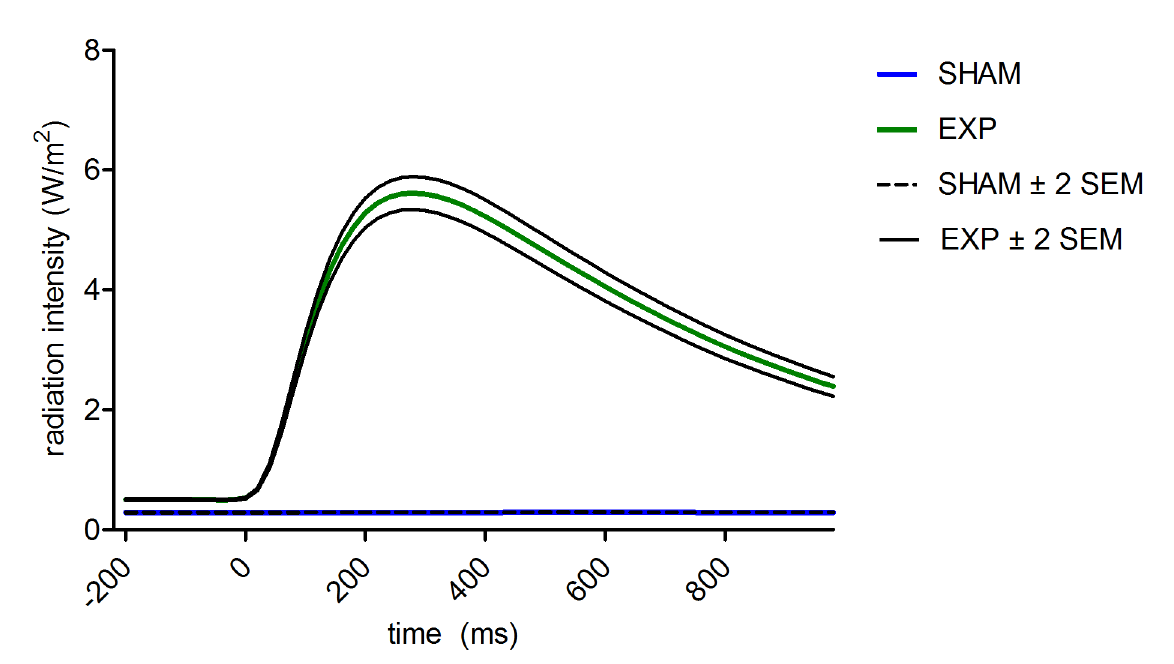
Fig 1. Mean radiation intensity of exposed and sham exposed epochs ± 2 standard error of the mean. The 4 grand averages of the non-conscious evoked related potentials of the twelve different locations are depicted in Fig 2. A visual inspection makes clear that the pre-stimulus baseline area (-200- 0ms) does not show remarkable differences between the four grand averages. In the post-stimulus area, the exposed ear session is the only condition which has a distinct course. This effect is especially prominent in the 240 – 500ms frontal and central post-stimulus areas. Except Fz and F4, in which a P300-like peak can be detected, the morphology is not similar to that of most conscious ERP responses: a N200 is missing and the ERP has a smaller amplitude in general. Moving from frontal to occipital, the ‘ P300 peak ’ seems to diminish and a later effect, from 500 – 1000ms, becomes more noticeable. These are no obvious visual left-right hemispherical differences. Fig 3 shows the topography of the grand